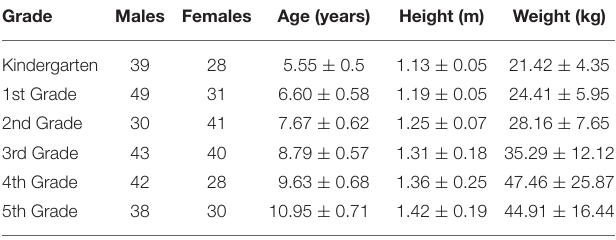
TABLE 1A | Descriptive and anthropometric data.